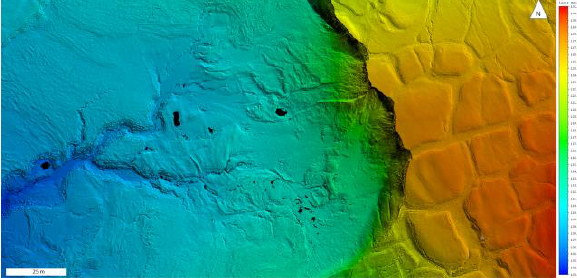
Figure 9. 10 cm pixel cell minimum elevation representation of a section of the data reveals even the tiny details of the topography. An interesting feature are the small ripples across the surface indicating slow flow of material. On the polygon edges the data could reconstruct the cracking of the soil, water flow patterns, and secondary polygon